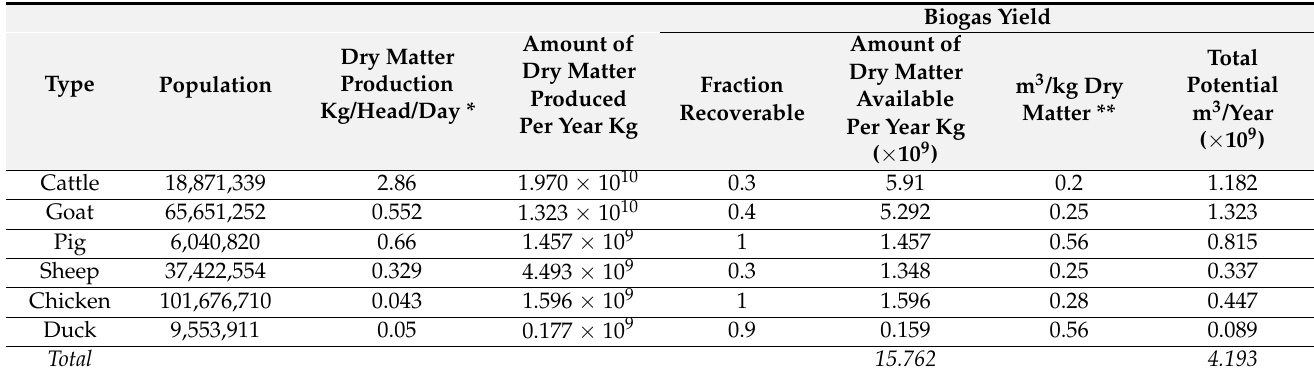
Table 8. Animal waste production and its potential for biogas in Nigeria (2010). Data taken from [56].